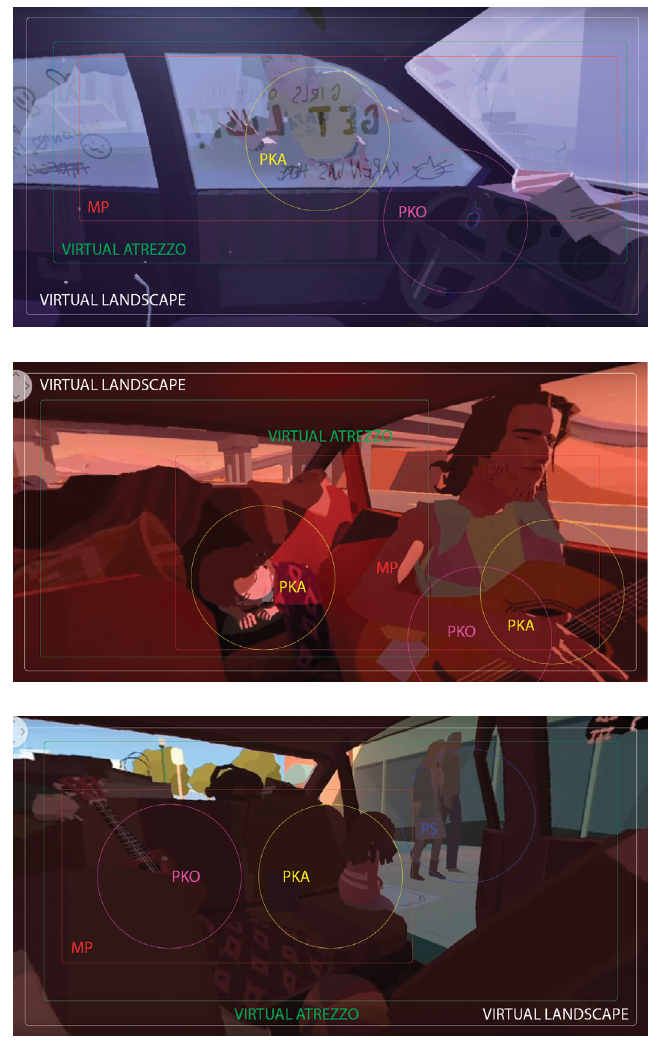
Figures 4, 5, 6. Identification of components in the virtual landscape of the 360º VR film Pearl (Osborne, 2016). The virtual atrezzo would be the set of components inside the car and outside on the street. The